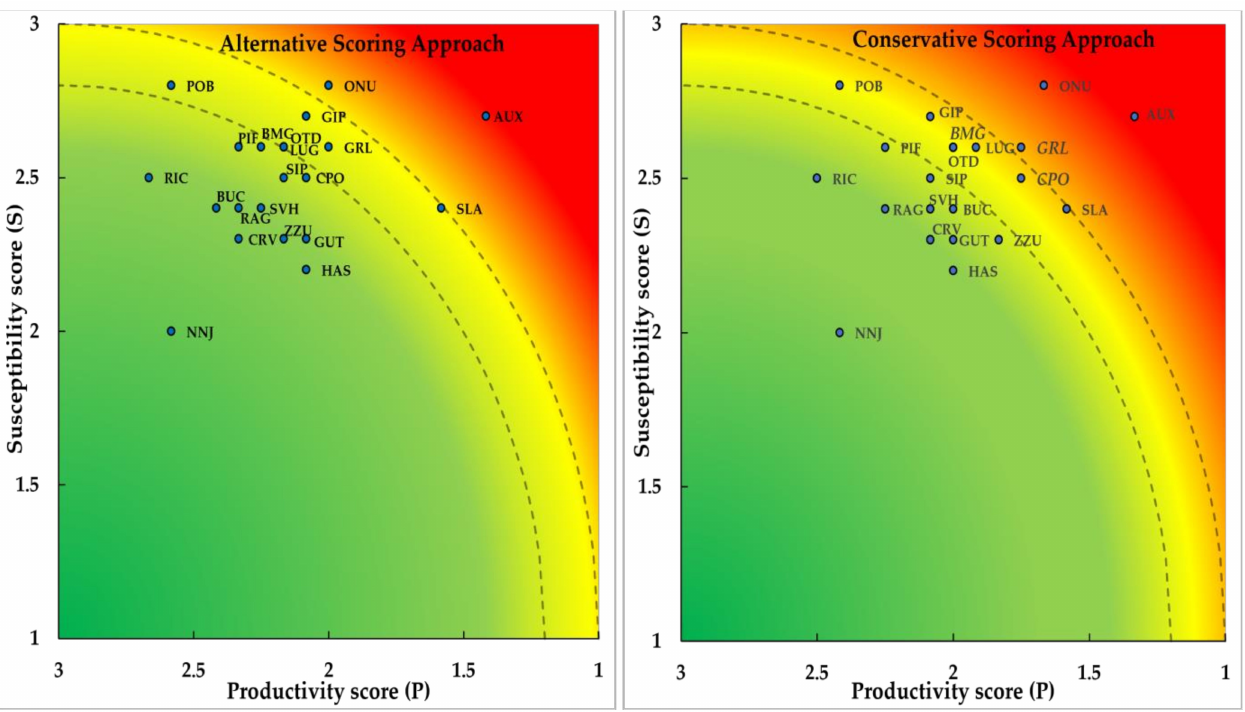
Figure 2. Two-dimensional productivity–susceptibility plot for the selected bycatches of the Hilsa gillnet fishery in Bangladesh using an alternative ( a ) and conservative ( b ) scoring approach. The dashed contour lines define the boundaries of the vulnerability categories ( V < 1.8 = low, 1.8 ≤ V < 2 = moderate, V ≥ 2 = high). The 3-alpha FAO species identification codes are provided in Table 1. The species codes in italic font (Figure 2b) indicate changes in the species vulnerability ranks between the two scoring